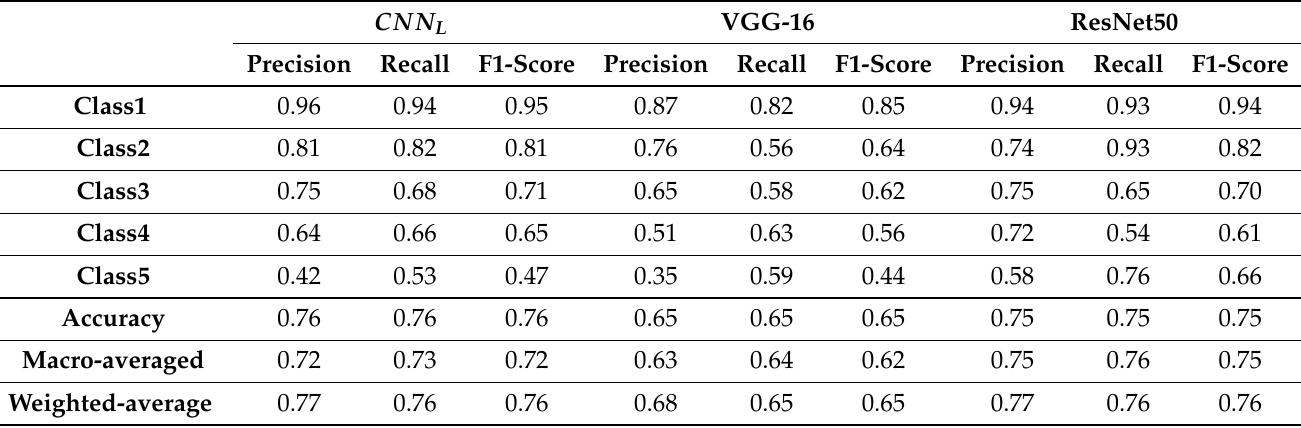
Table 3. Patch-wise classification accuracy for our proposed CNN L and VGG-16 network using precision, recall, F1-score, accuracy, macro-averaged, and